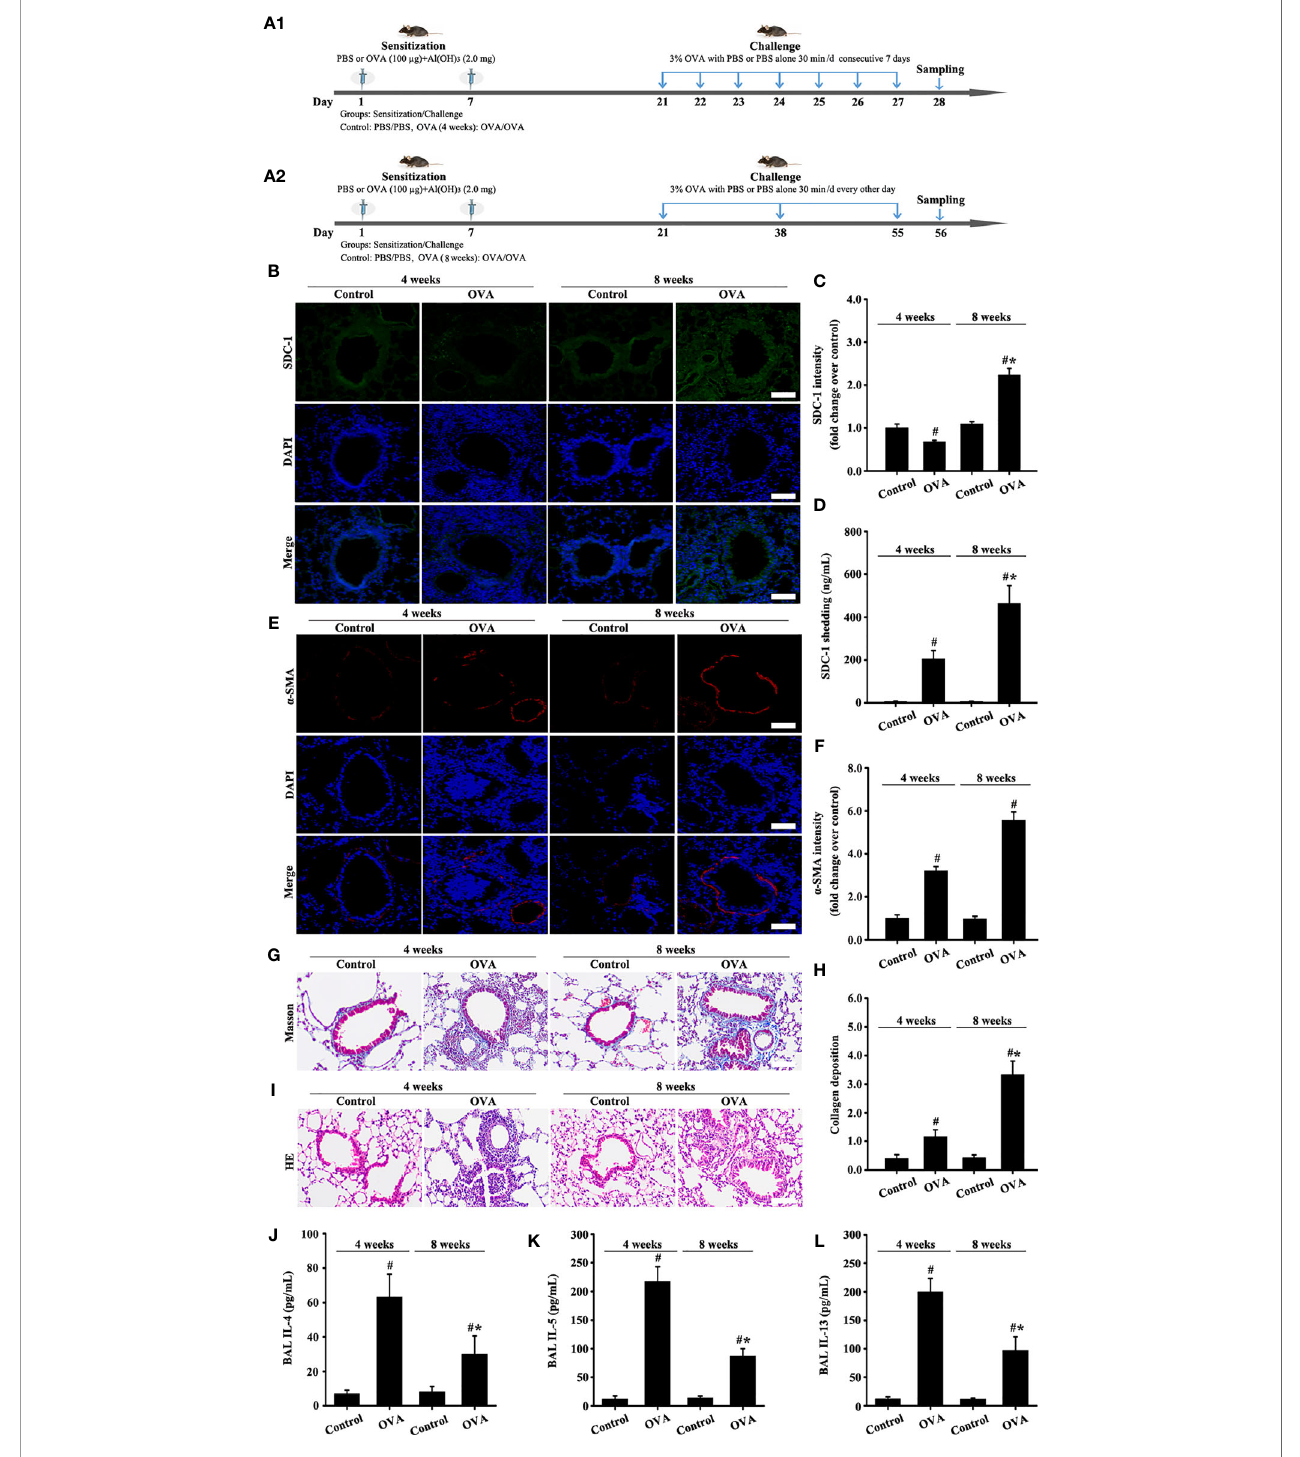
FIGURE 2 | Animal experimental schedule is shown in (A) . SDC-1 (B) and a -SMA (E) levels were detected by immuno fl uorescence. Collagen deposition was evaluated by Masson staining (G) . Histopathologic changes were detected by HE staining (I) . Levels of SDC-1 shedding (D) , IL-4 (J) , IL-5 (K) , and IL-13 (L) in BALF were measured by ELISA. (C, F) immuno fl uorescence intensity analysis of (B, E). (H) collagen deposition intensity analysis of (G) Data are shown as the means ± SD of three independent experiments. # p < 0.05 versus the control group. # *p < 0.05 versus the OVA (4 weeks) or control